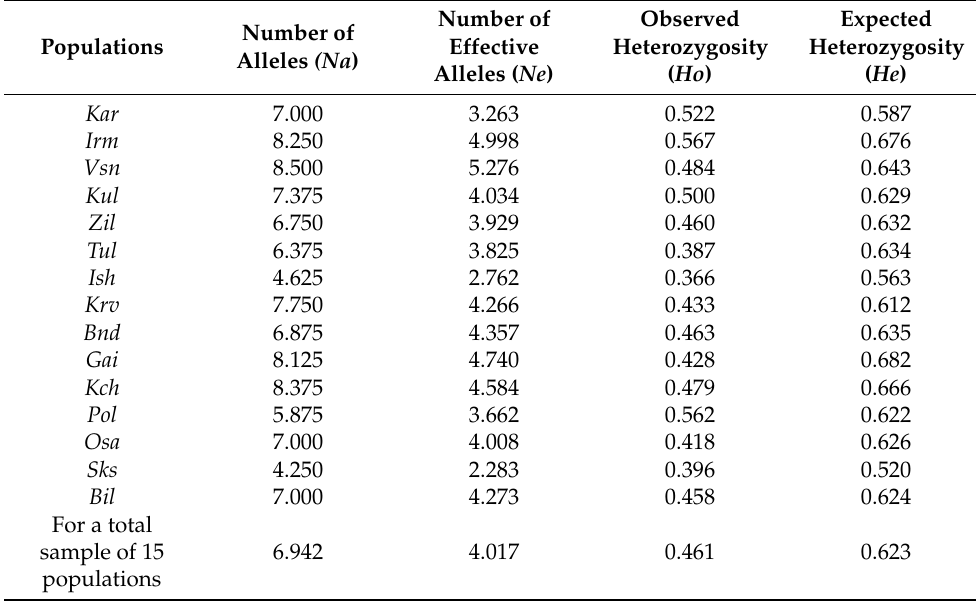
Table 2. Genetic diversity of 15 populations of L. sibirica based on polymorphisms of microsatellite markers. Populations